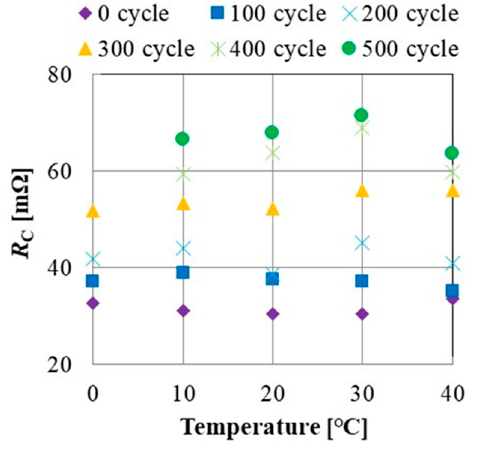
Figure 12. Effect of charging cycle on corrected R C .